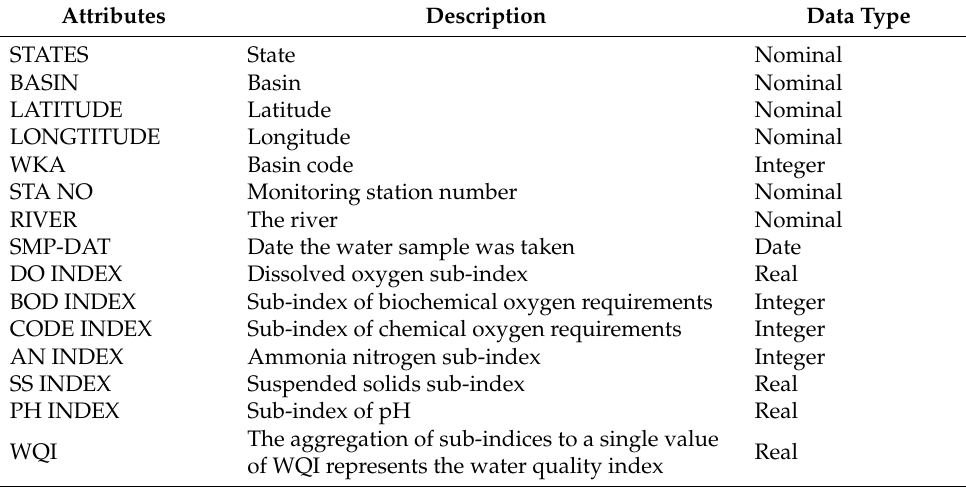
Table 1. WQI-JAS